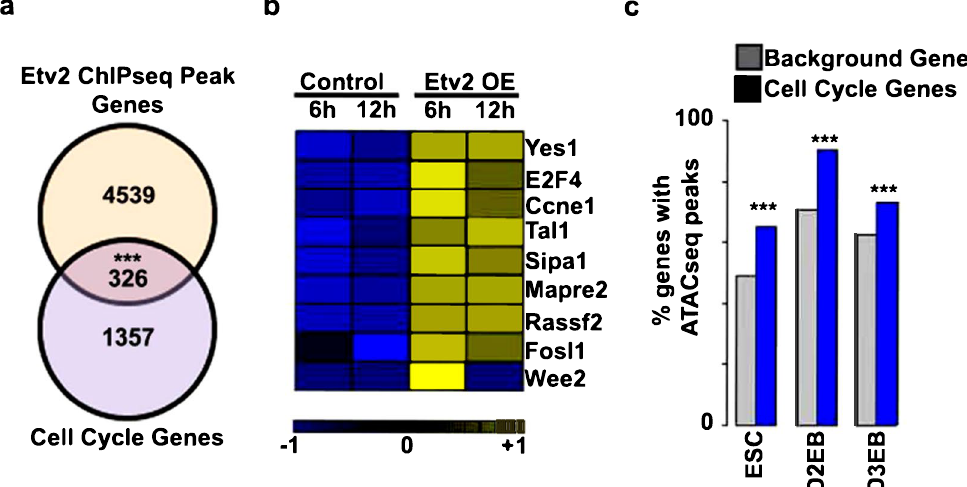
Figure 1. ChIPseq, ATACseq, and bulk RNAseq showed significant enrichment of cell cycle transcripts following induction of Etv2 in the ES/EB system. ( a ) Venn diagram of the overlap between genes associated with Etv2 ChIPseq peaks 25 and genes annotated to the cell cycle GO-classification. The significance was confirmed using the Fisher Exact Test. ( b ) Heat map of bulk RNAseq analyses of the previously published datasets 10 using iHA - Etv2 ES/EBs showing increased expression of cell cycle genes in Dox-induced EBs relative to uninduced EBs. Note the increased expression of cell cycle genes following the induction of HA-Etv2 at both time points. ( c ) ATACseq analysis using iHA - Etv2 ESCs, D2 EBs, and D3 EBs following Dox treatment for 24 h. Note that there was significantly (p < 0.001) higher percentage of ATACseq peaks within the cell cycle genes as compared to background genes in the Dox-treated samples ( *** p <